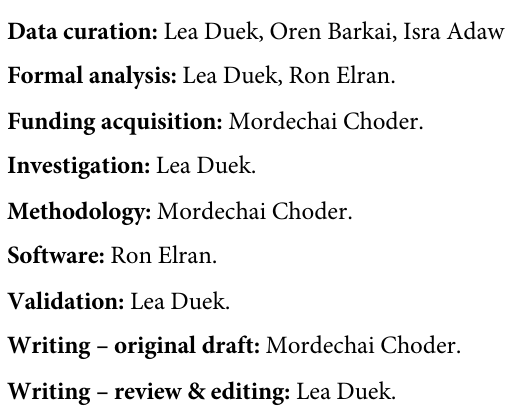
S1 Fig. (A) Level of Tet-off-RPB2 product as a function of time after doxycycline addition. (B). RPB2-RPB4 cells proliferate more slowly than WT cells in a co-culture S2 Fig. [Lack of] Correlation between mRNA decay rates in RPB2-RPB4 cells against vari- ous mutant strains, each carries a deletion in a certain gene encoding mRNA decay factor. S3 Fig. Detection of free Rpb4 using different methods of protein extraction. S4 Fig. Cells that express ~ one half of the normal level of Rpb4 can proliferate like WT at high